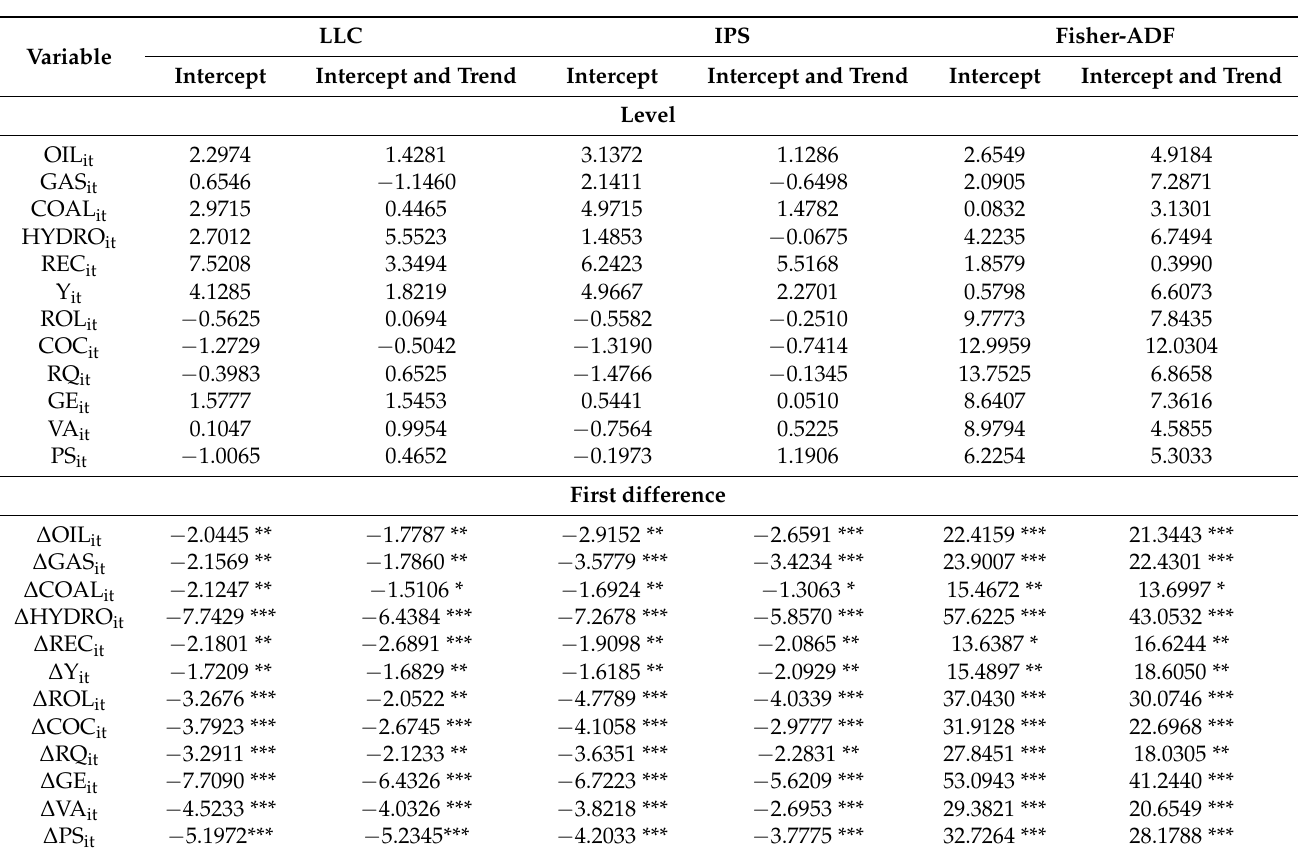
Table 3. Panel unit root